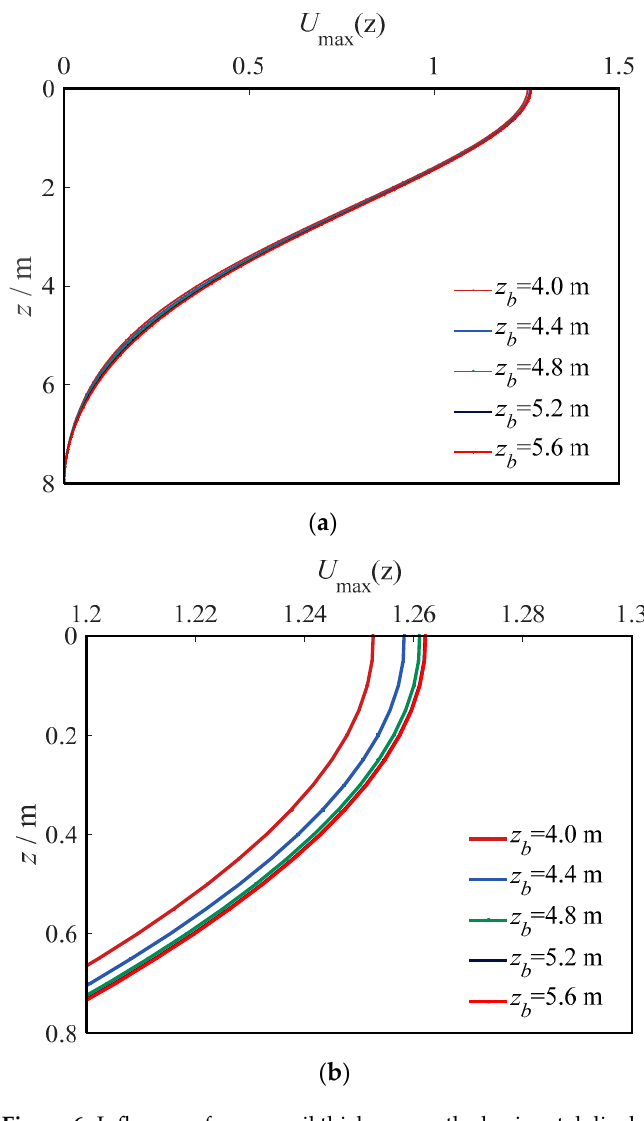
Figure 6. Influence of upper soil thickness on the horizontal displacement of pile body. ( a ) Horizontal displacement of TP (depth 0~8 m) and ( b ) horizontal displacement of TP (depth 0~0.8 m).